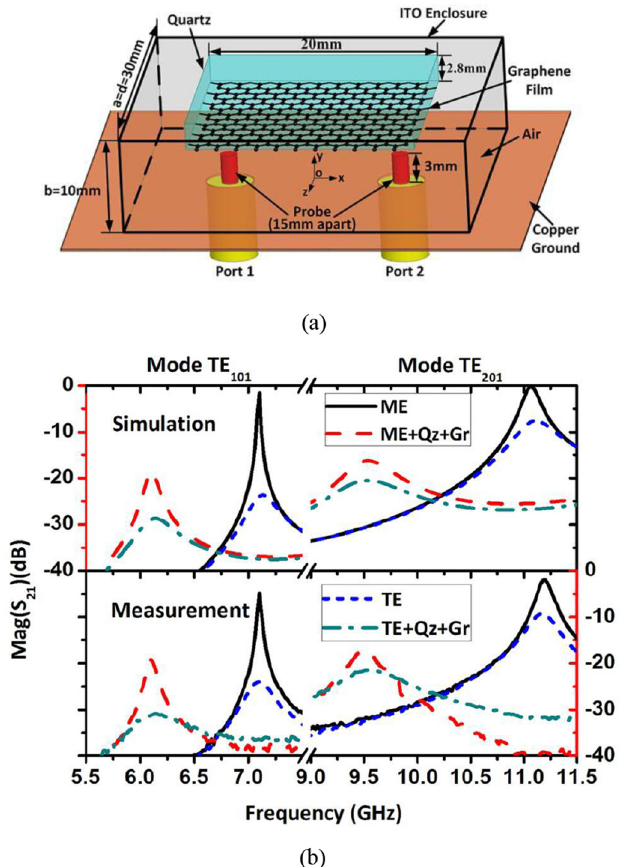
Fig. 10. (a) The con fi guration of the transparent electromag- netic shielding enclosure. (b) Simulated and measured transmis- sion coef fi cients of the metallic enclosure (ME) and ITO transparent enclosure (TE). The status of the two enclosures after graphene (Gr) fi lm and quartz (Qz) imbedded is illustrated.